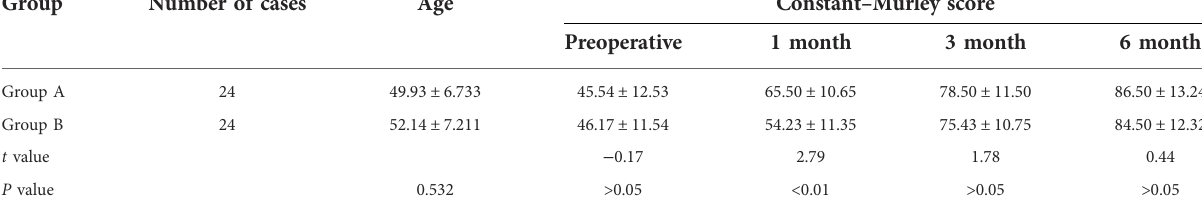
TABLE 1 Comparison of Constant – Murley scores at each follow-up point in the two groups. Group